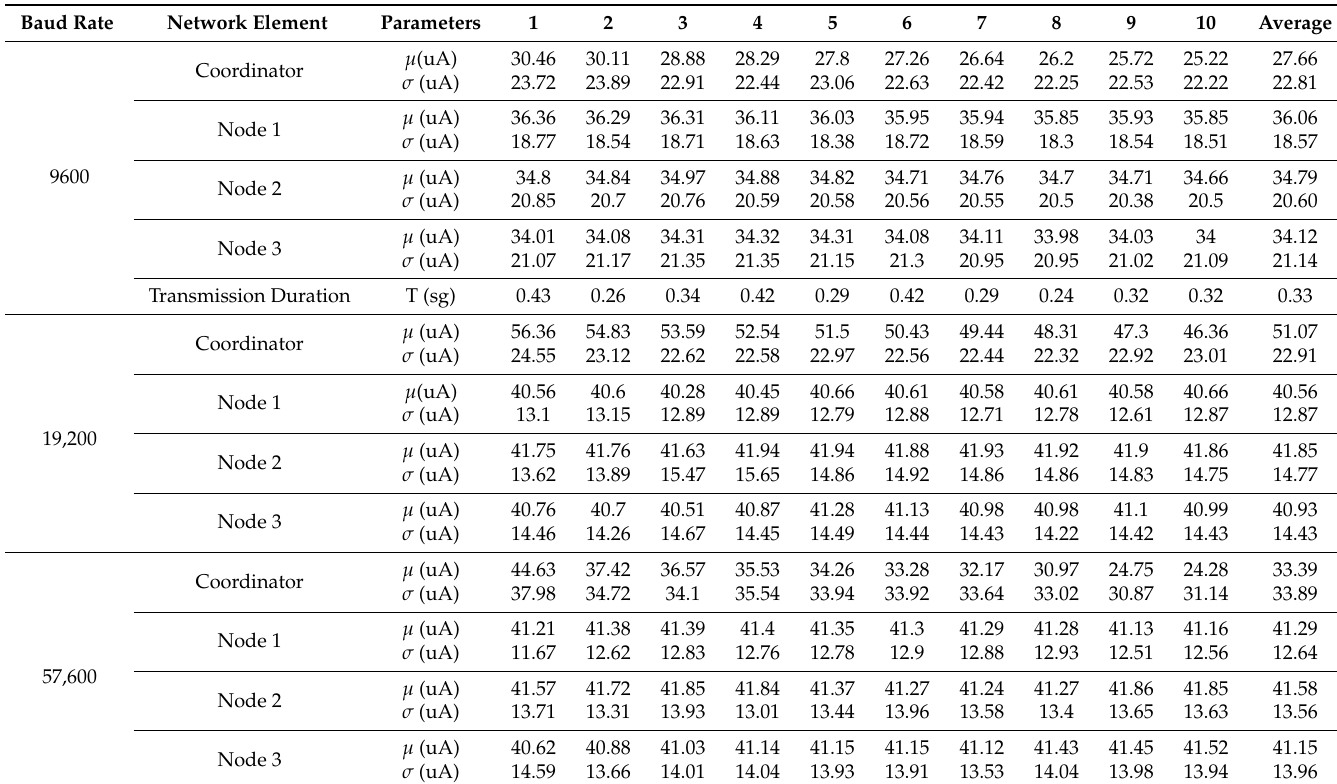
Table 4. Values of energy consumption and transmission duration for the ZigBee